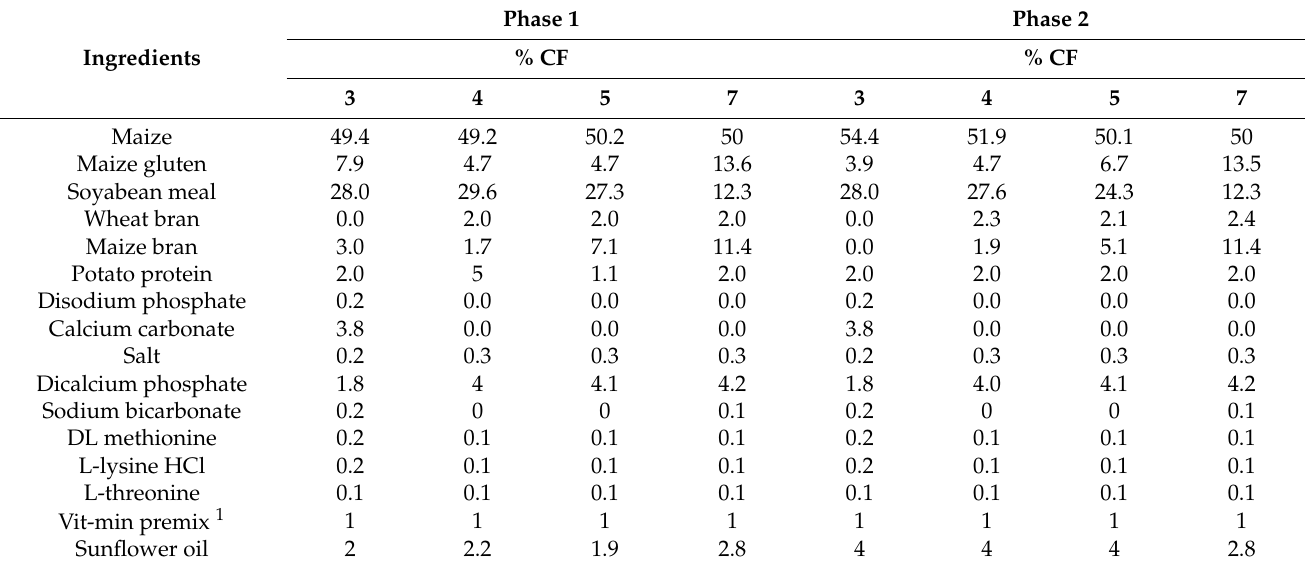
Table 1. Ingredients (%) of the experimental diets used in Phases 1 and